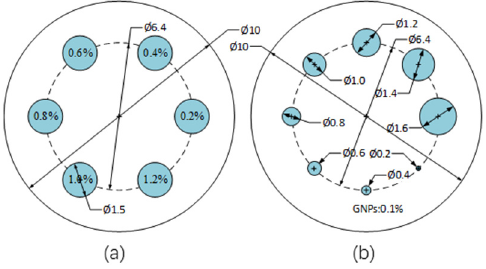
Figure 4. Phantoms inserted by cylinders with GNPs. ( a ) six cylinders with same diameter but different Au weight concentration. ( b ) eight cylinders with different diameters but same Au weight concentration.